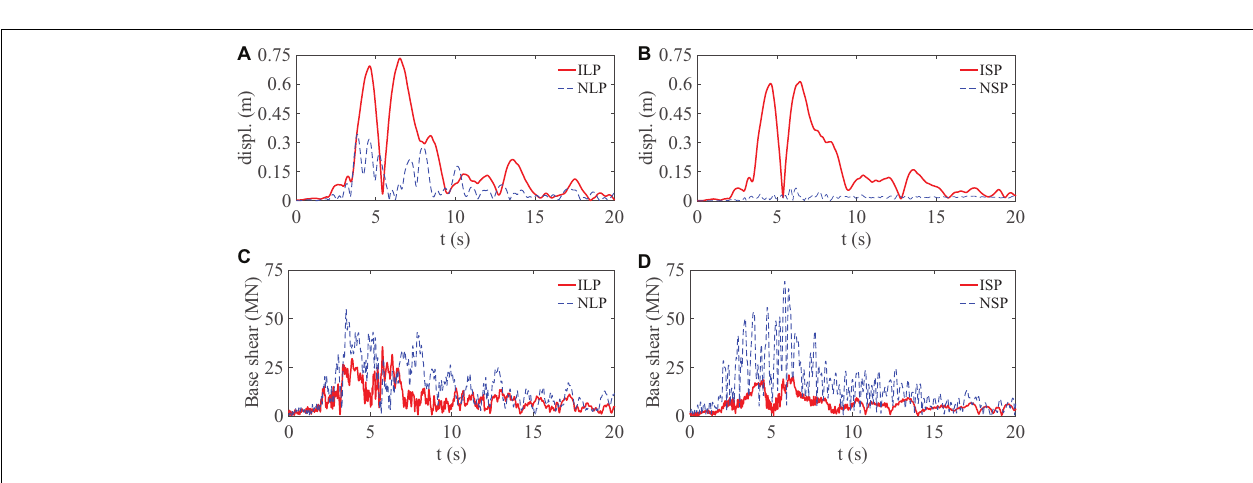
FIGURE 7 | The mean value of the maximum resultant displacement responses under the FF record pairs at piers P 1 to P 13 : (A) long-pier models; (B) short-pier models.